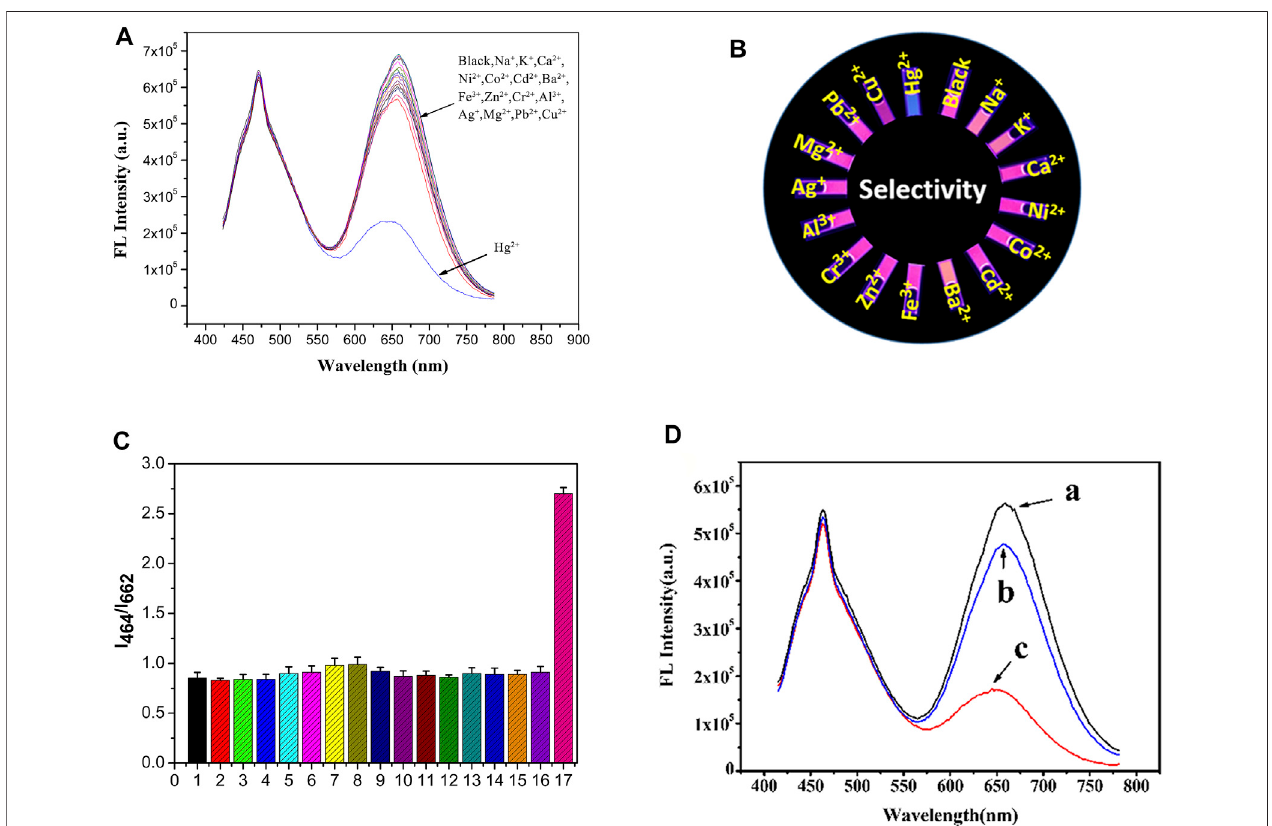
FIGURE 5 | (A) Schematic diagram of the selective responses of the ratio fl uorescent probe solutions to metal ions; (B) The corresponding fl uorescence photos; (C) The histogram shows the selective responses of the fl uorescence intensity (I464/I662) of the probe solutions to different metal cations, samples marked 1 – 17 represent1.Blank,2.Na + ,3.K + ,4.Ca 2+ ,5.Ni 2+ ,6.Co 2+ ,7.Cd 2+ ,8.Ba 2+ ,9.Fe 3+ ,10.Zn 2+ ,11.Cr 3+ ,12.Al 3+ ,13.Ag + ,14.Mg 2+ ,15.Pb 2+ ,16.Cu 2+ ,17.Hg 2+ ; (D) The anti-interference performance of the ratio fl uorescent probes; (A) without any addition of metal ions. (B) The addition of 25 μ M of metal cations mentioned above together. (C) A subsequent addition of 2.5 μ M Hg 2+ in (B) .